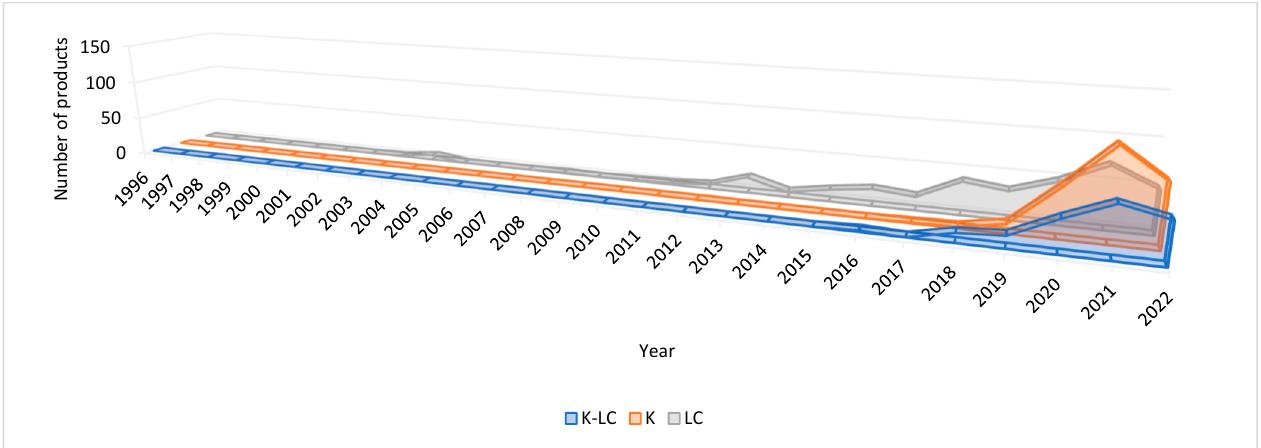
Figure 1. Evolution of the number of gluten-free bakery products labeled ketogenic low carb (K-LC), ketogenic (K), and/or low carb (LC).